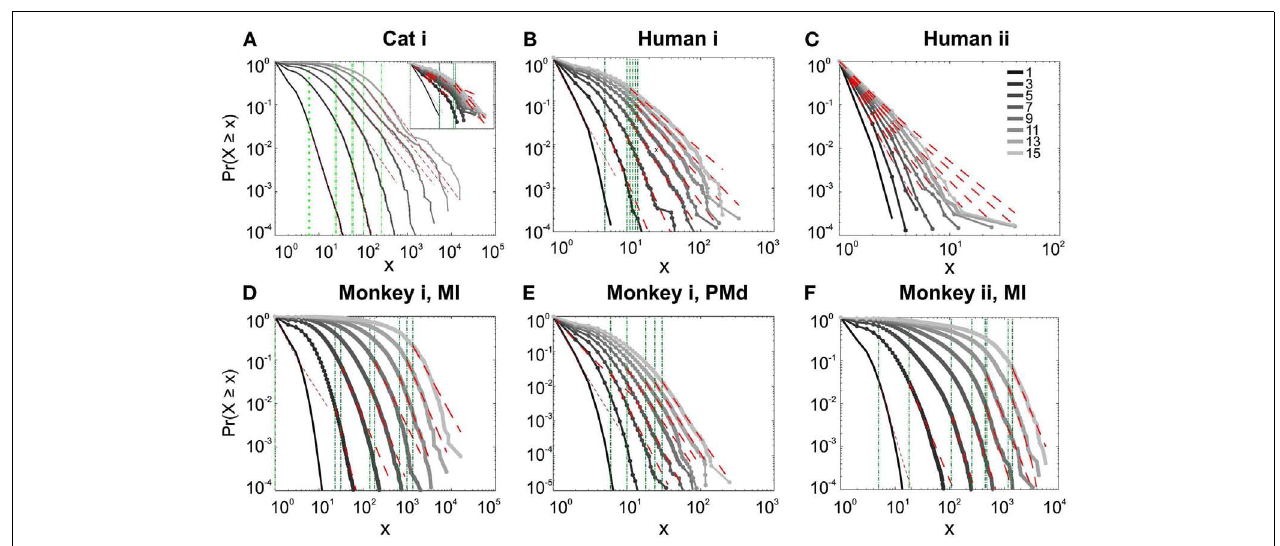
exponents had very high values, well above the criticality regime that is hypothesized for 1/ f noise. (D–F) Show the same type of curves for monkeys engaged in cognitive motor task (96 electrode array; augmented with a 64 electrode array). Same pattern is observed; it also seems MI has slightly higher values than PMd in the plausible power-law regime. For the mean/STD exponent values, see Tables 1 and 2 .